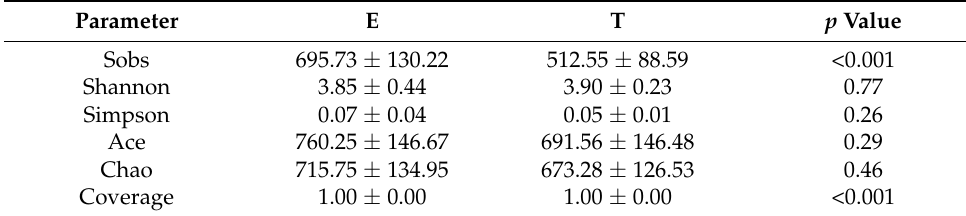
Table 3. Indexes of the intestinal flora diversity of the sleep—disordered group before and after exercise intervention.